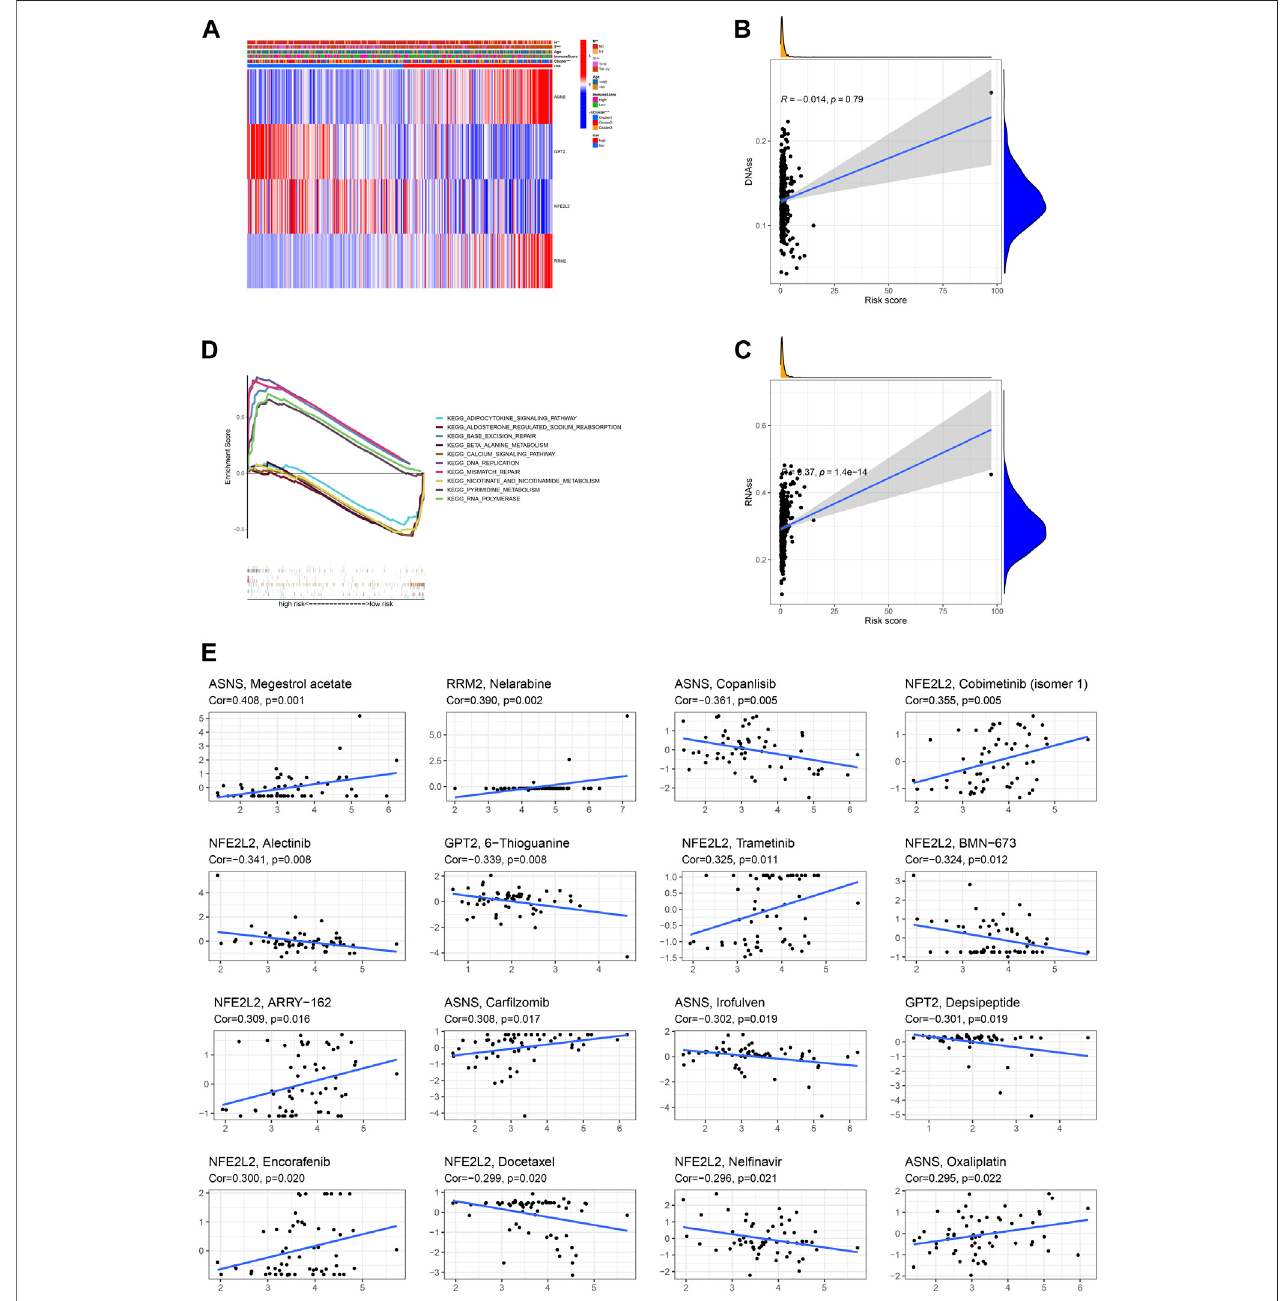
FIGURE 9 | Association of the ferroptosis-based signature with clinicopathologic features (A) , cancer stemness (B,C) , functional enrichment (D) , anti-cancer sensitivity (E) .